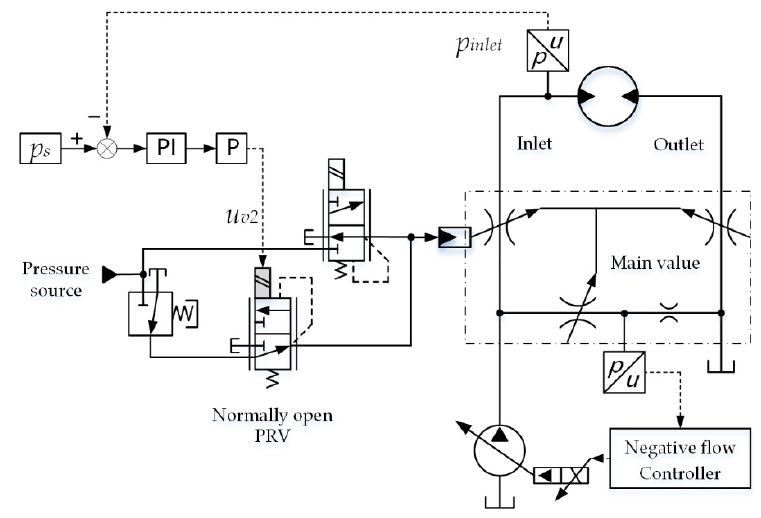
Figure 4. Schematic diagram of motor acceleration control (compound-swing).